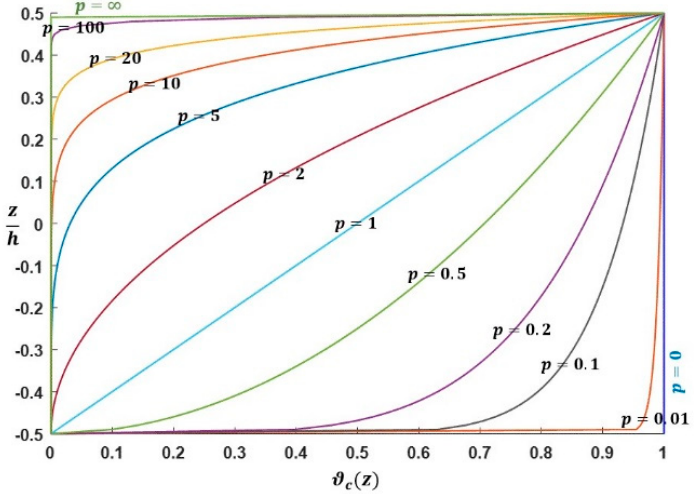
Figure 2. Ceramic volume proportion profile across the FG beam thickness, for different material indexes .